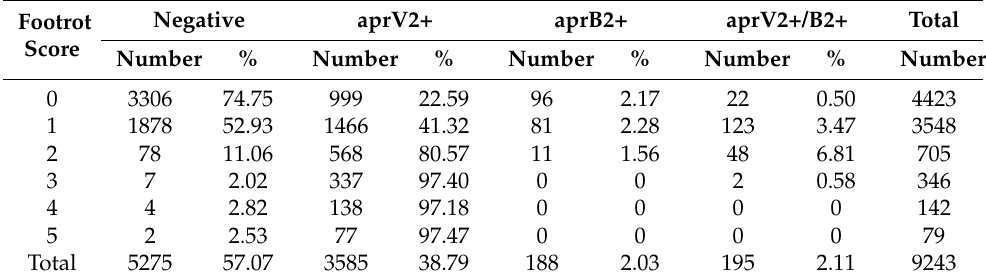
Table 6. Joint distribution of clinical signs of footrot and Dichelobacter nodosus